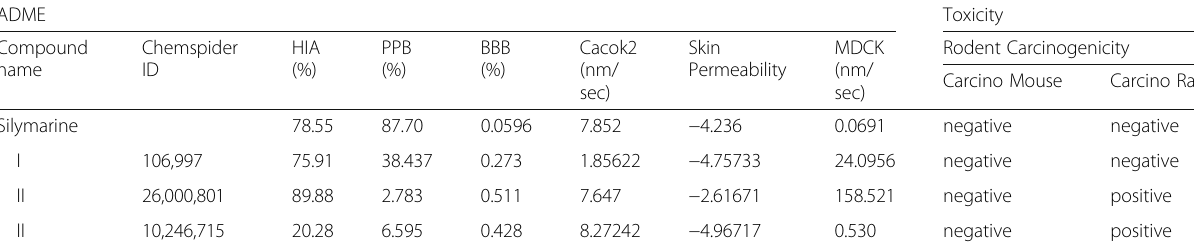
Table 4 ADME and toxic properties